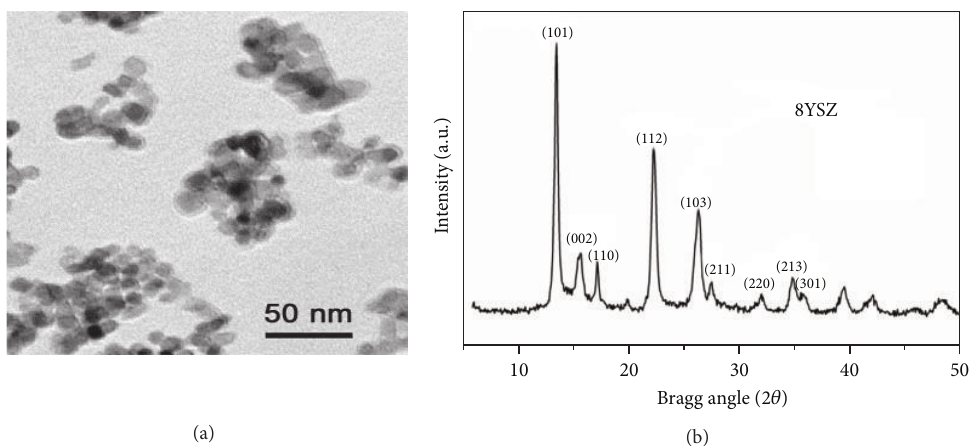
Figure 2: TEM micrograph and XRD pattern of as-synthesized YSZ particles.